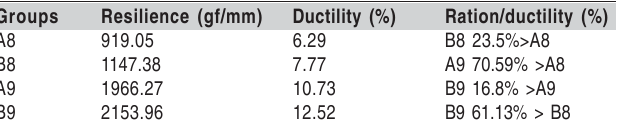
Table 2. Values regarding resilience and ductility of the bars.